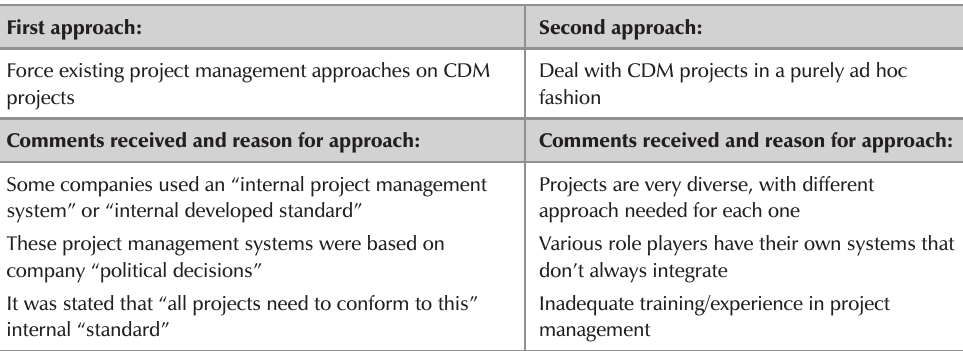
Summary of comments regarding CDM project management models